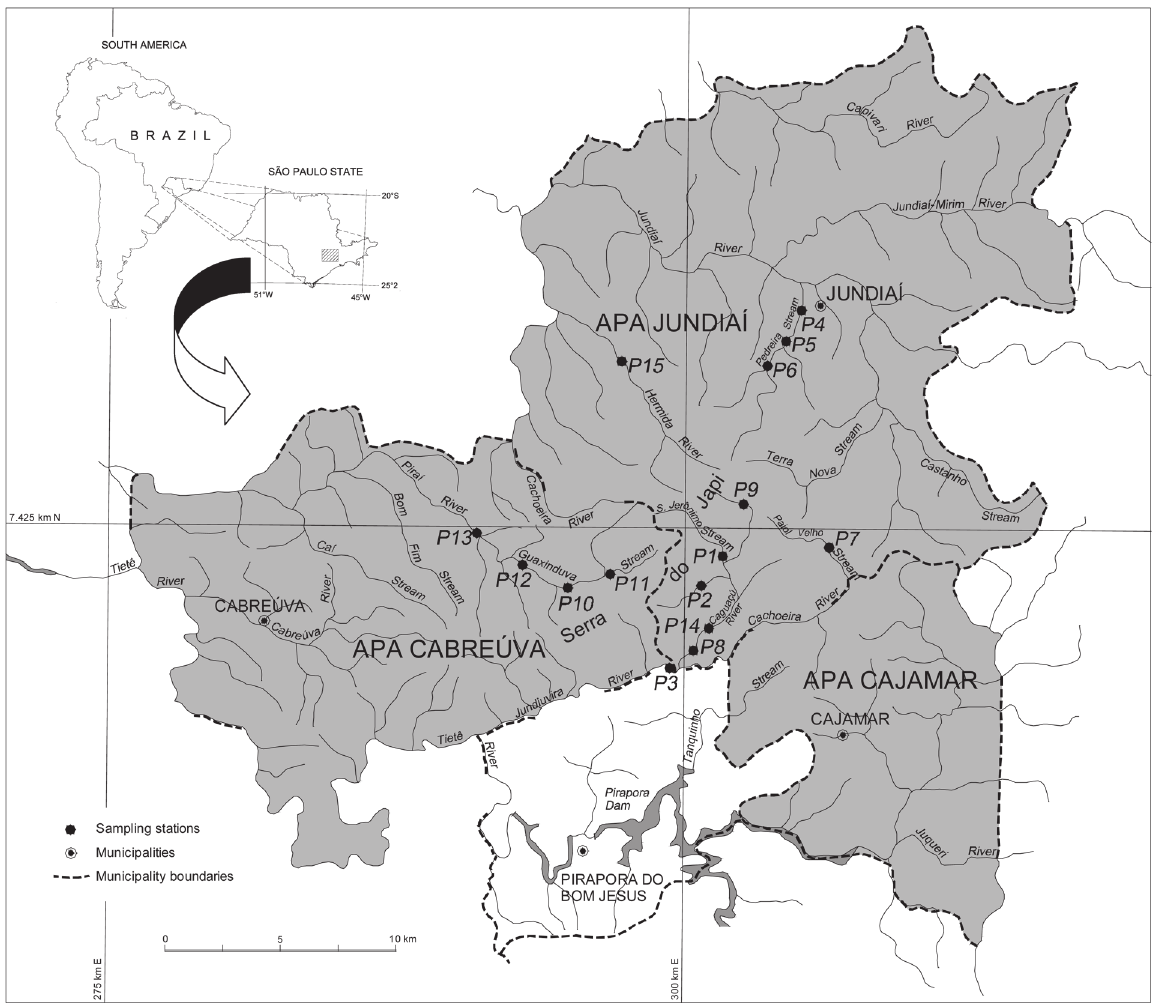
Fig. 1. Location of the Serra Japi in the APAs of Jundiaí, Cabreúva, Cajamar and in the municipality of Pirapora do Bom Jesus (SP), showing sampling sites in the different streams. Adapted from “Atlas das Unidades de Conservação Ambiental do Estado de São Paulo- Parte II-Interior, SMA,